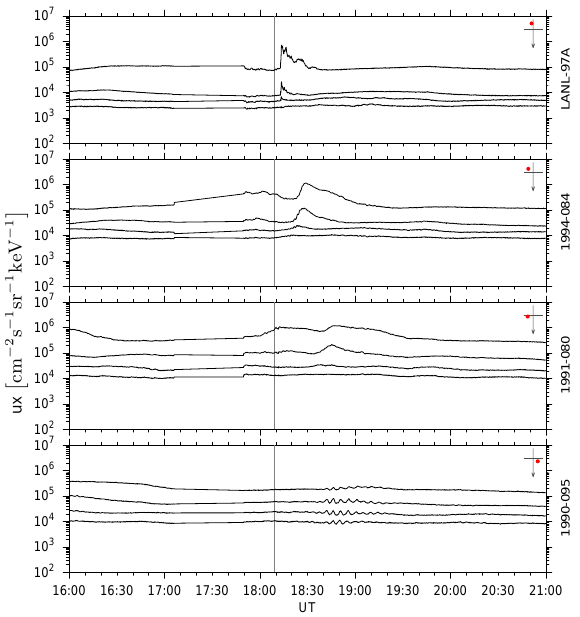
Fig. 2. Perturbations in the H component of the magnetic field at ground stations (a) Yinchuan [YCB] and (b) Kakioka [KAK]. The waveforms are bandpass filtered over the Pi2 frequency range. onset precedes the activity at the other satellites and its form is highly irregular, quite distinct from the symmet- Table 1. Location of the Cluster satellites during the event on ric envelopes on the remaining satellites. It is reasonable 21 January 2003, given in Cartesian GSE coordinates [distances to conclude that the dynamics of the Pi2, if observed on measured in Earth radii, R E ], McIlwain’s (1961) parameter, mag- C3, differ significantly from those on the other spacecraft. netic latitude ( λ ) and magnetic local time (MLT). Positions were One cannot, however, exclude the possibility that other transformed from GSE to Solar Magnetic (SM) coordinates and a Fig. 3: EFW probe potential on 21 January 2003. waves with similar spectral content mask the event at C3. centred dipole magnetic field was assumed when calculating L , λ and MLT. The position of each satellite with respect to the plas- masphere is indicated symbolically ( × = inside plasmasphere; | = on plasmapause; ◦ = outside FGM data. The perturbations reflected in Figure 4c may in part be due to these field-aligned currents.